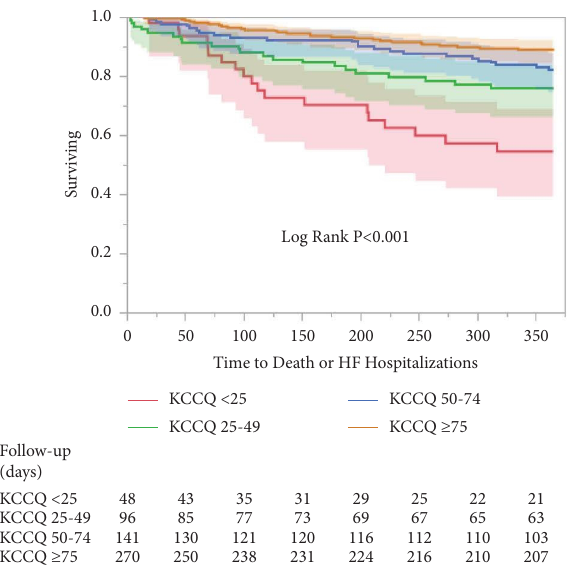
Figure 2: Kaplan–Meier survival estimates for mortality or heart failure hospitalizations at 1 year follow-up. Plots reveal a higher incidence of the primary endpoint in the lower compared to higher KCCQ groups. Table 2: Clinical